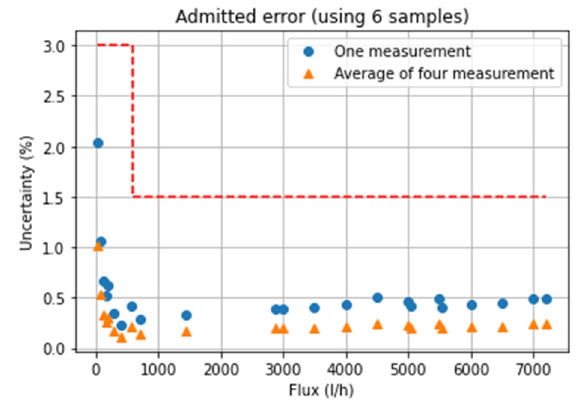
Figure 25. Achieved uncertainty.